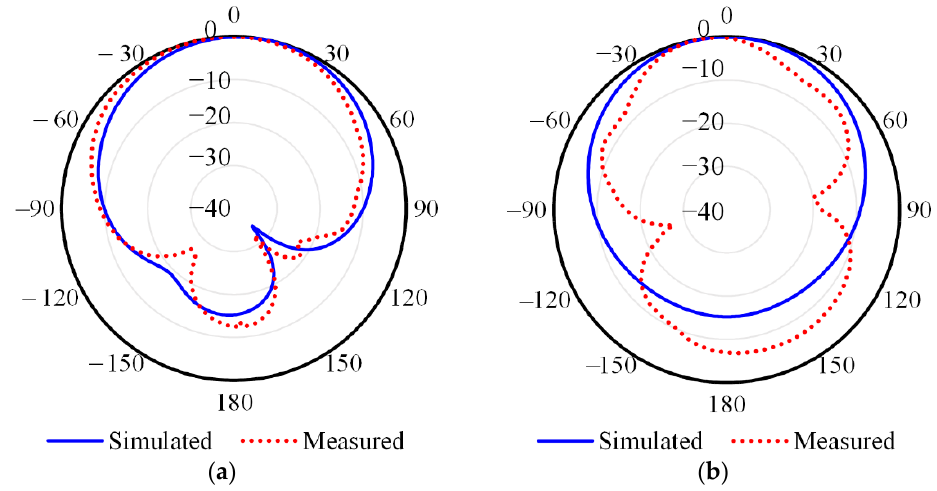
Figure 23. The simulated and measured radiation pattern of the single band antenna (using RT Du- roid substrate) at 2.4 GHz on ( a ) E-plane and ( b ) H-plane.